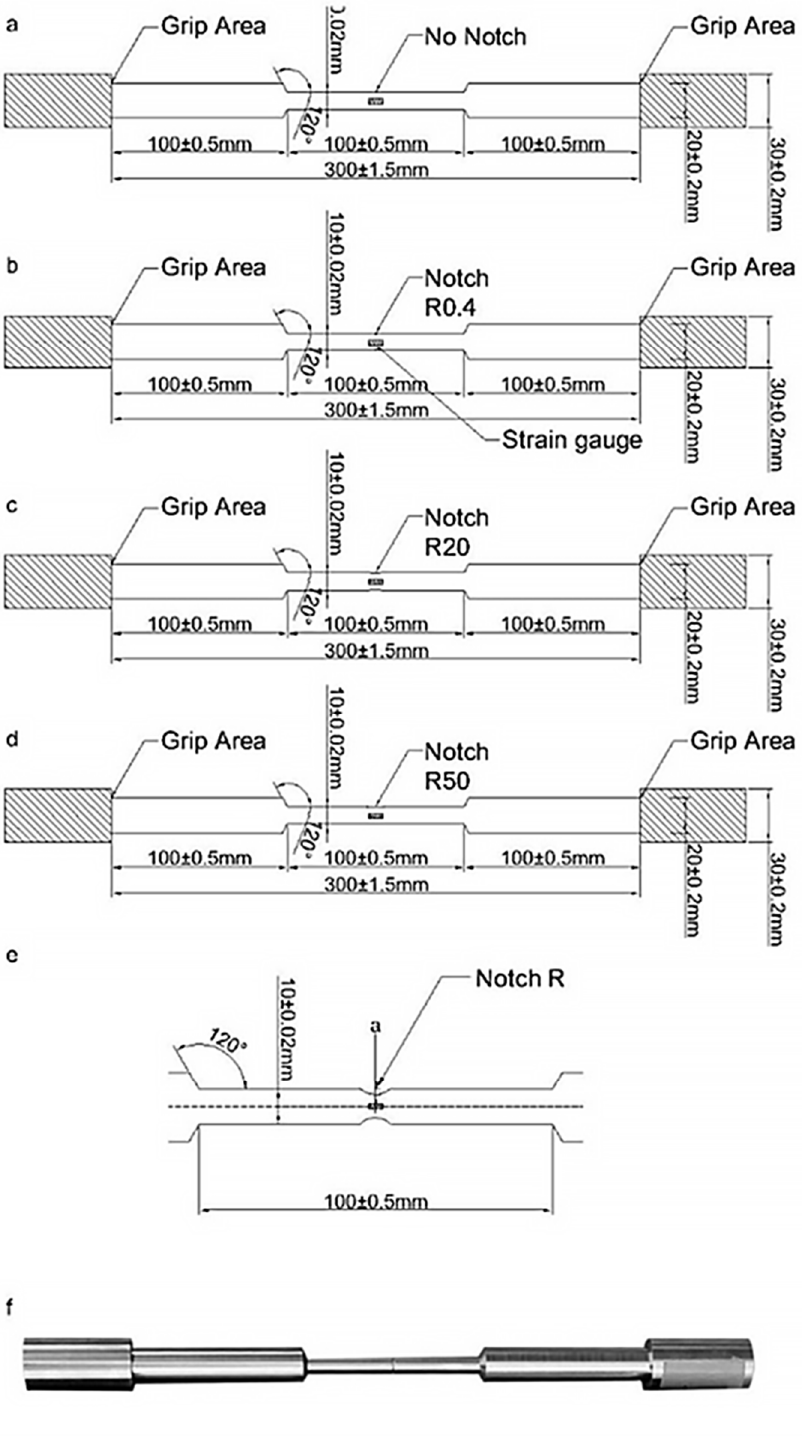
Figure 2. Geometrical details of specimens for tensile tests at ( a ) smooth-type quasi-static and dynamic strain rates, ( b ) notched R0.4 type, ( c ) notched R20 type, ( d ) notched R50 type and ( e ) detailed representation of notched region; ( f ) typical manufactured specimen.